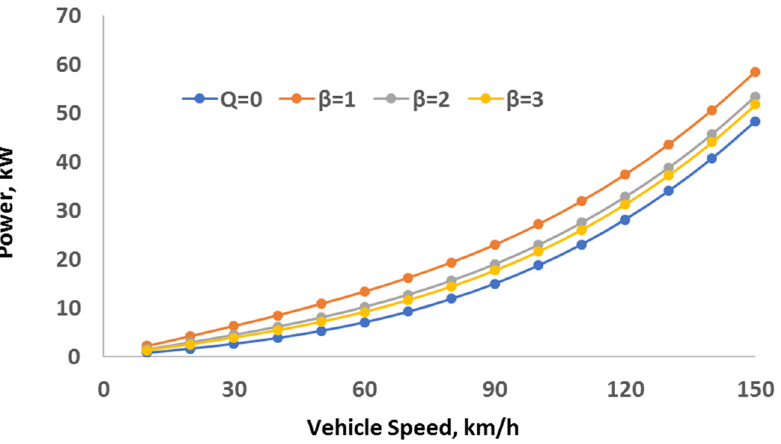
Figure 4. Power needed for EVs as a function of the vehicle speed and the coefficient of performance of the heat pump for Δ T = 30 °C.